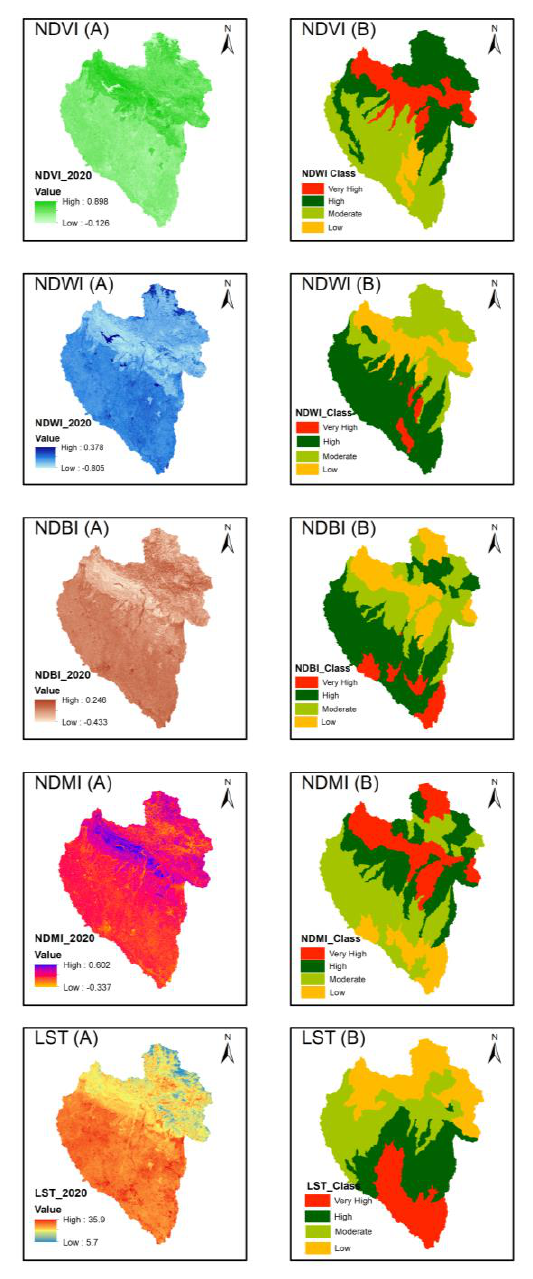
Figure 3. Land Cover Indices and